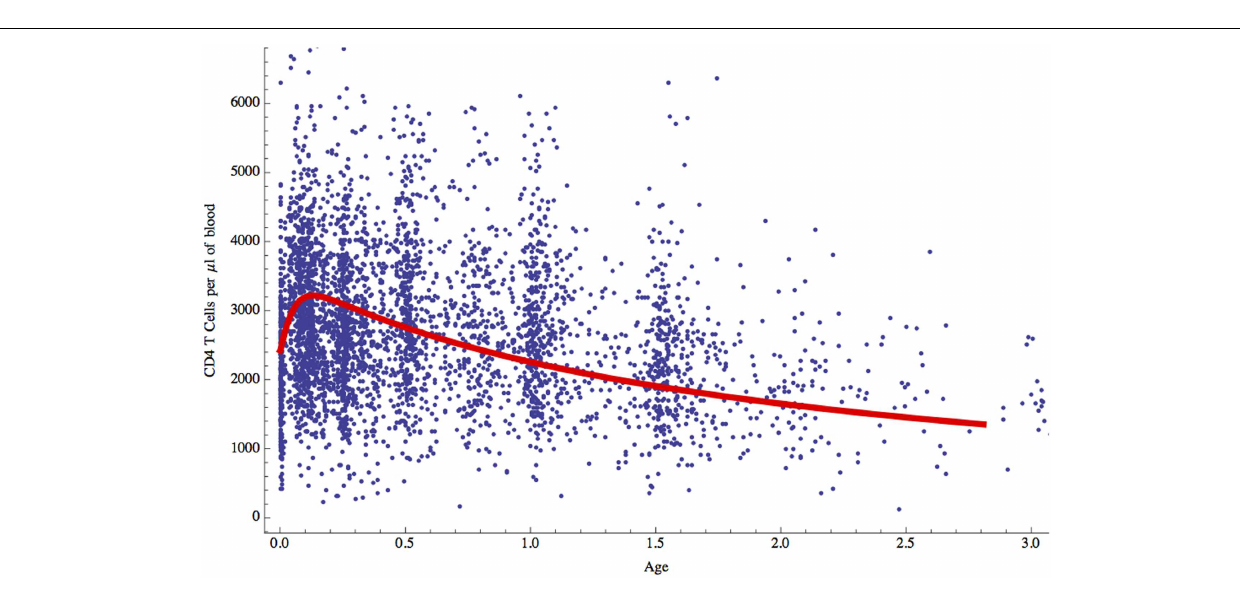
FIGURE 6 | Naive CD4T cell concentrations (cells/ µ l of blood) predicted by the model for children aged 0–3years (red curve) compared with clinical data for normal children